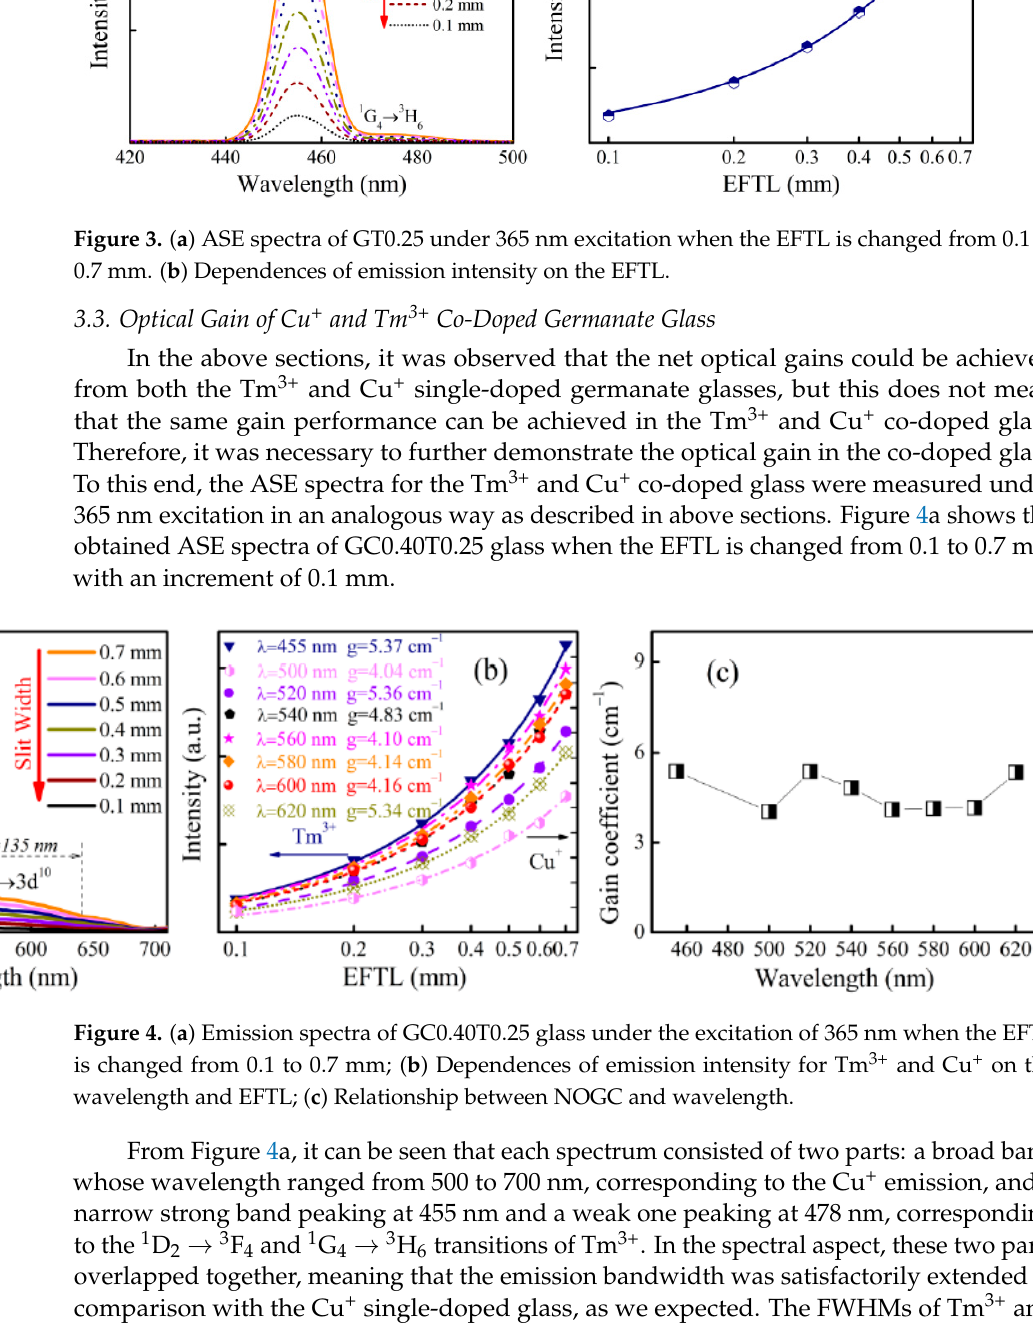
Figure 3. ( a ) ASE spectra of GT0.25 under 365 nm excitation when the EFTL is changed from 0.1 to 0.7 mm. ( b ) Dependences of emission intensity on the EFTL.